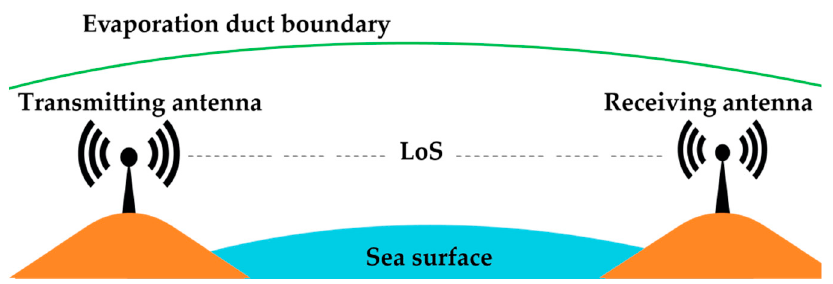
Figure 4. An example of line-of-sight (LoS) propagation pathway.